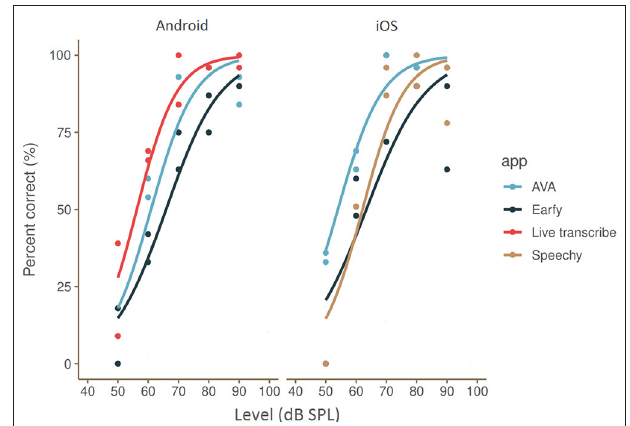
FIGURE 2 | Speech recognition as a function of presentation level (in human listeners known as speech audiogram) of all ASR apps tested on an Android and iOS smartphone. The plotted lines are interpolated using a logistic function through the measured test-retest data-points. Left side, results of the Android apps, right side, results of the iOS apps.